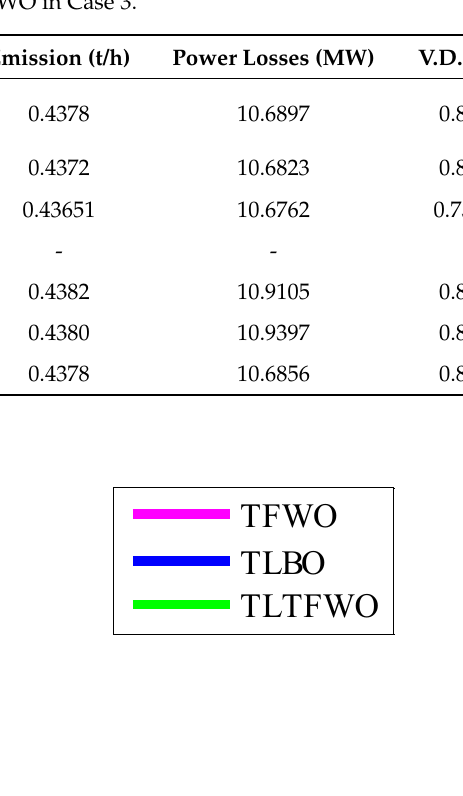
Table 6. Optimal results found by the TLTFWO in Case 3.